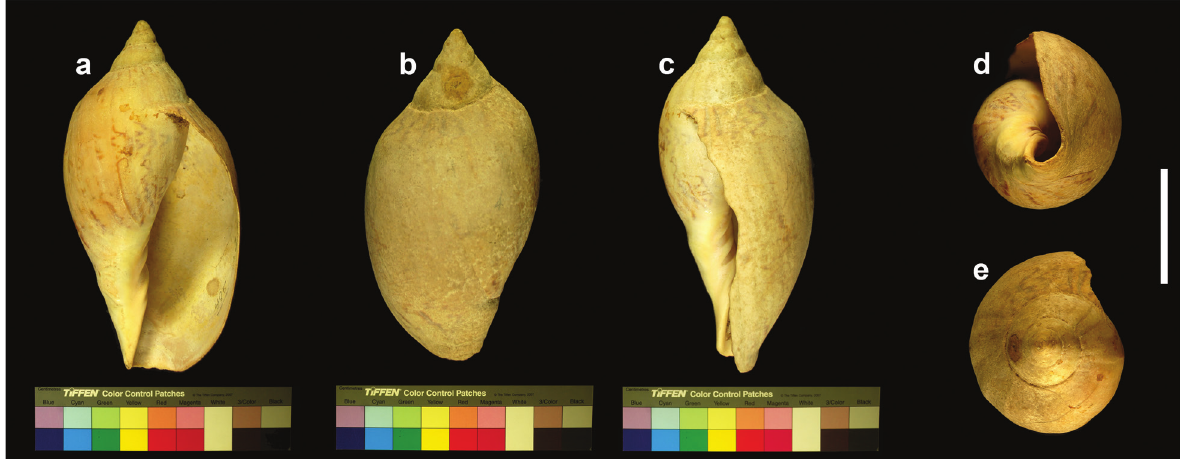
Figure 11. Voluta ancilla inflata , holotype. a Apertural view b Dorsal view c Lateral view d Umbilical view e Apical view. Scale bar: 5 cm.